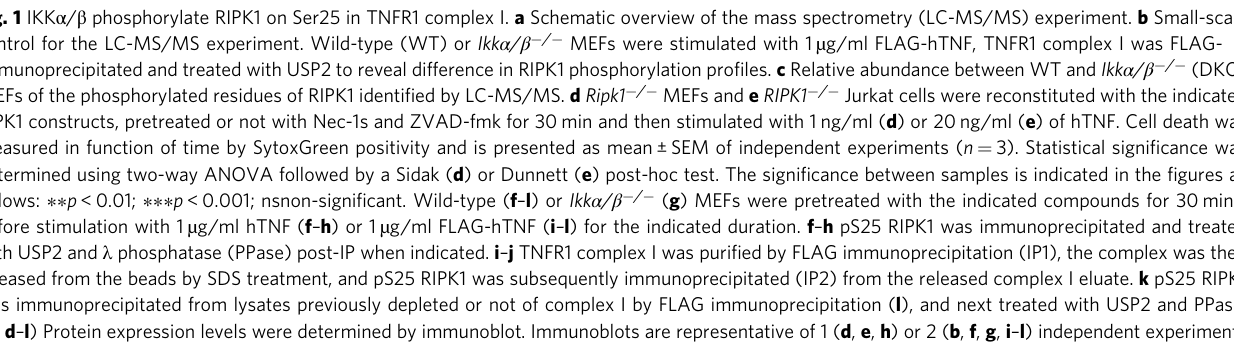
Fig. 1 IKK α / β phosphorylate RIPK1 on Ser25 in TNFR1 complex I. a Schematic overview of the mass spectrometry (LC-MS/MS) experiment. b Small-scale control for the LC-MS/MS experiment. Wild-type (WT) or Ikk α / β − / − MEFs were stimulated with 1 µ g/ml FLAG-hTNF, TNFR1 complex I was FLAG- immunoprecipitated and treated with USP2 to reveal difference in RIPK1 phosphorylation pro fi les. c Relative abundance between WT and Ikk α / β − / − (DKO) MEFs of the phosphorylated residues of RIPK1 identi fi ed by LC-MS/MS. d Ripk1 − / − MEFs and e RIPK1 − / − Jurkat cells were reconstituted with the